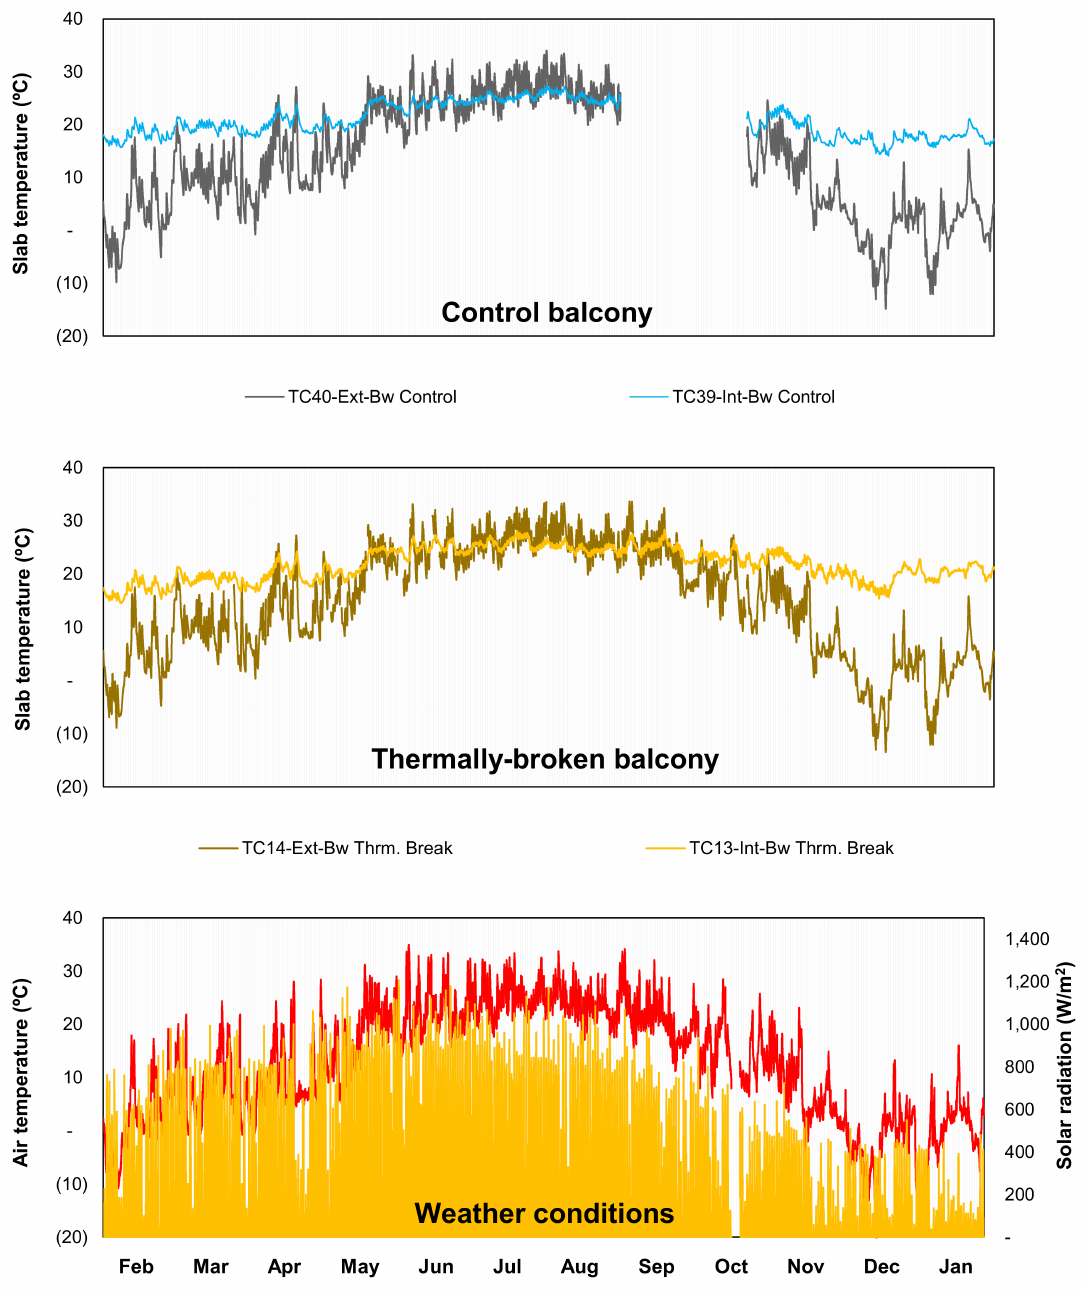
Figure A6. Experimental data for balcony pair